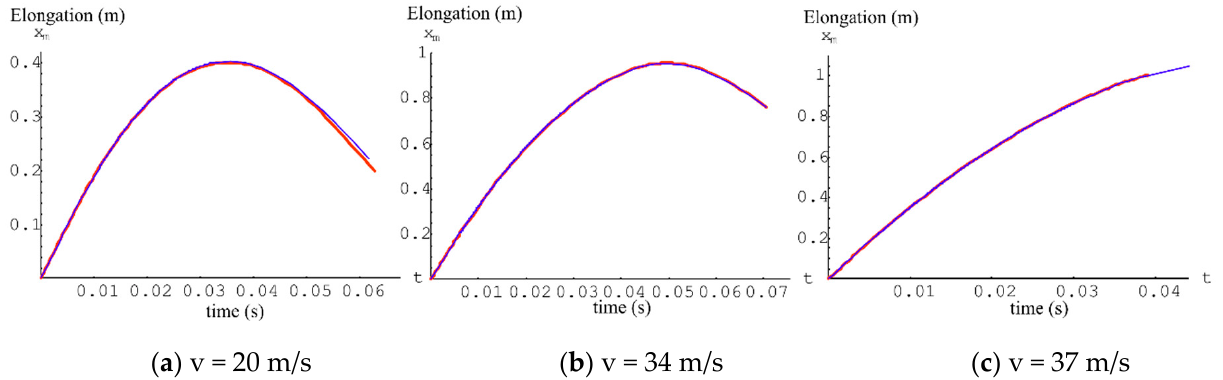
Figure 9. Forced responses at various initial velocities (v = 20 m/s, 34 m/s, 37 m/s). Number of segments = 100, red line: approximate solution, blue line: exact solution.